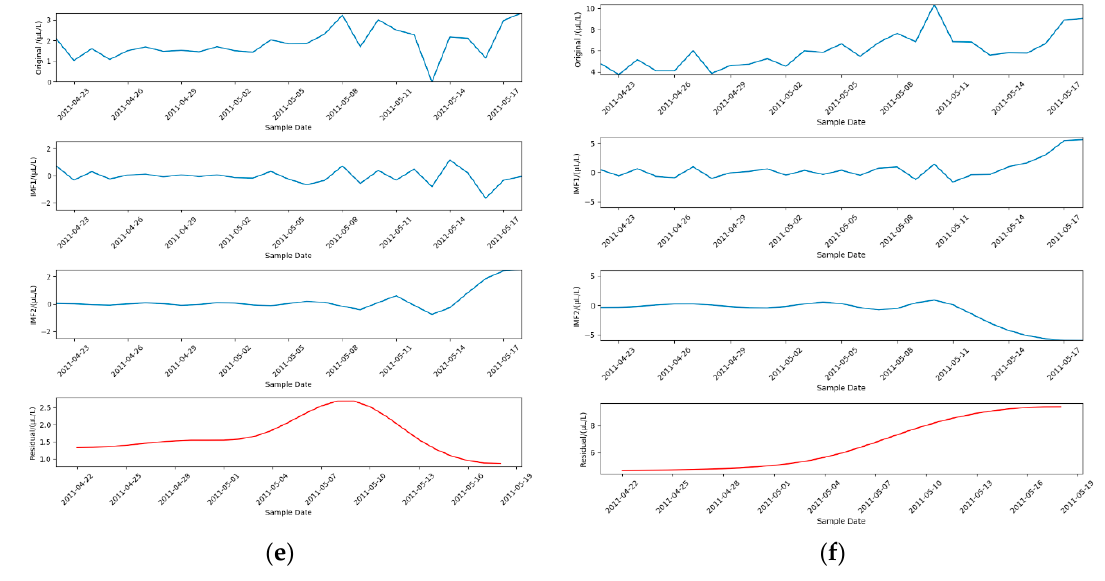
Figure 4. EMD results of the dissolved gas concentration. ( a ) H 2 ; ( b ) CH 4 ; ( c ) C 2 H 6 ; ( d ) C 2 H 2 ; ( e ) C 2 H 4 and ( f ) total hydrocarbon.